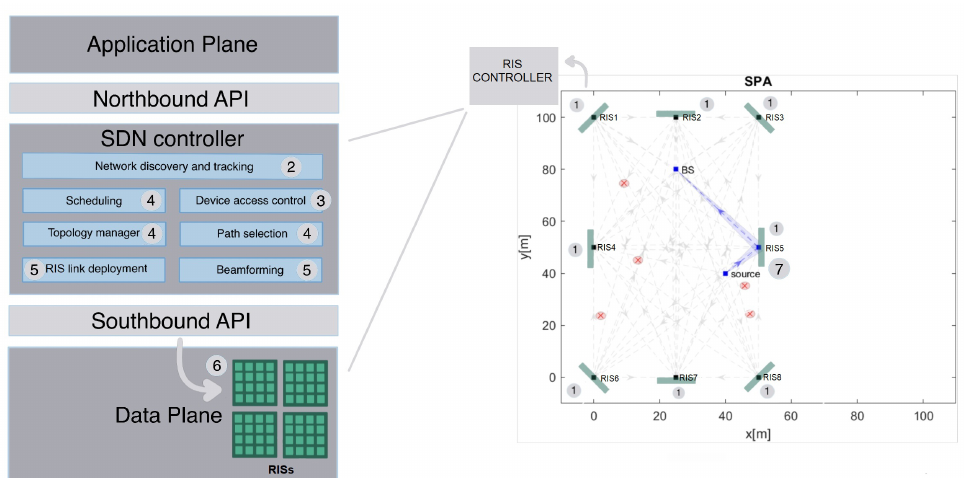
Figure 1. Proposed SDN-oriented system architecture, where the Control Plane is decomposed into functional blocks interacting with the local RIS